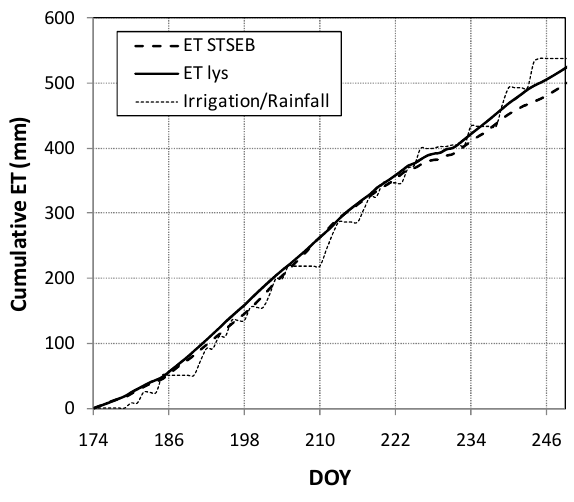
(b) 2 Figure 6. Modelled (STSEB) versus measured (lys) sorghum evapotranspiration: (a) 3 hourly values, (b) daily values. Results of the linear regression fit, together with the 4 main statistics of the comparison (Bias, RMSD, and MAPD), are also included. 5